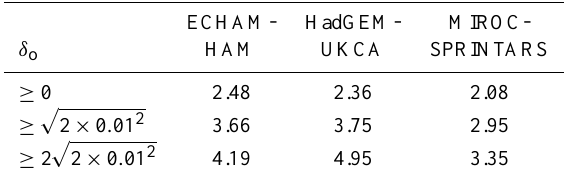
Table 2. Median ratio of daily AOT variation δ o /δ m across all AERONET sites. Only sites with more than two observations for at least 24days during 3months were used. Since the estimated er- ror in AERONET AOT measurements is 0.01, the error in measured p δ o can be no more than 2 × 0 . 01 2 . ECHAM- HadGEM- MIROC- δ o HAM UKCA SPRINTARS ≥ 0